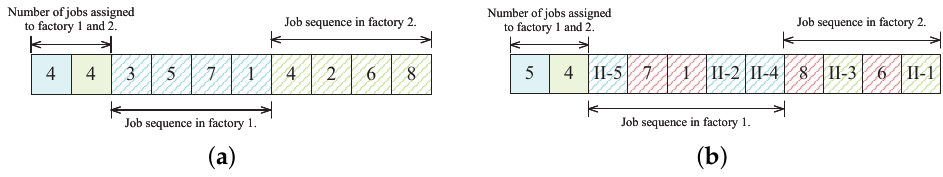
Figure 2. A feasible solution of an instance of EDHFRP; ( a ) A feasible solution before new job arrival; ( b ) The solution after order O 2 ’s arrival.